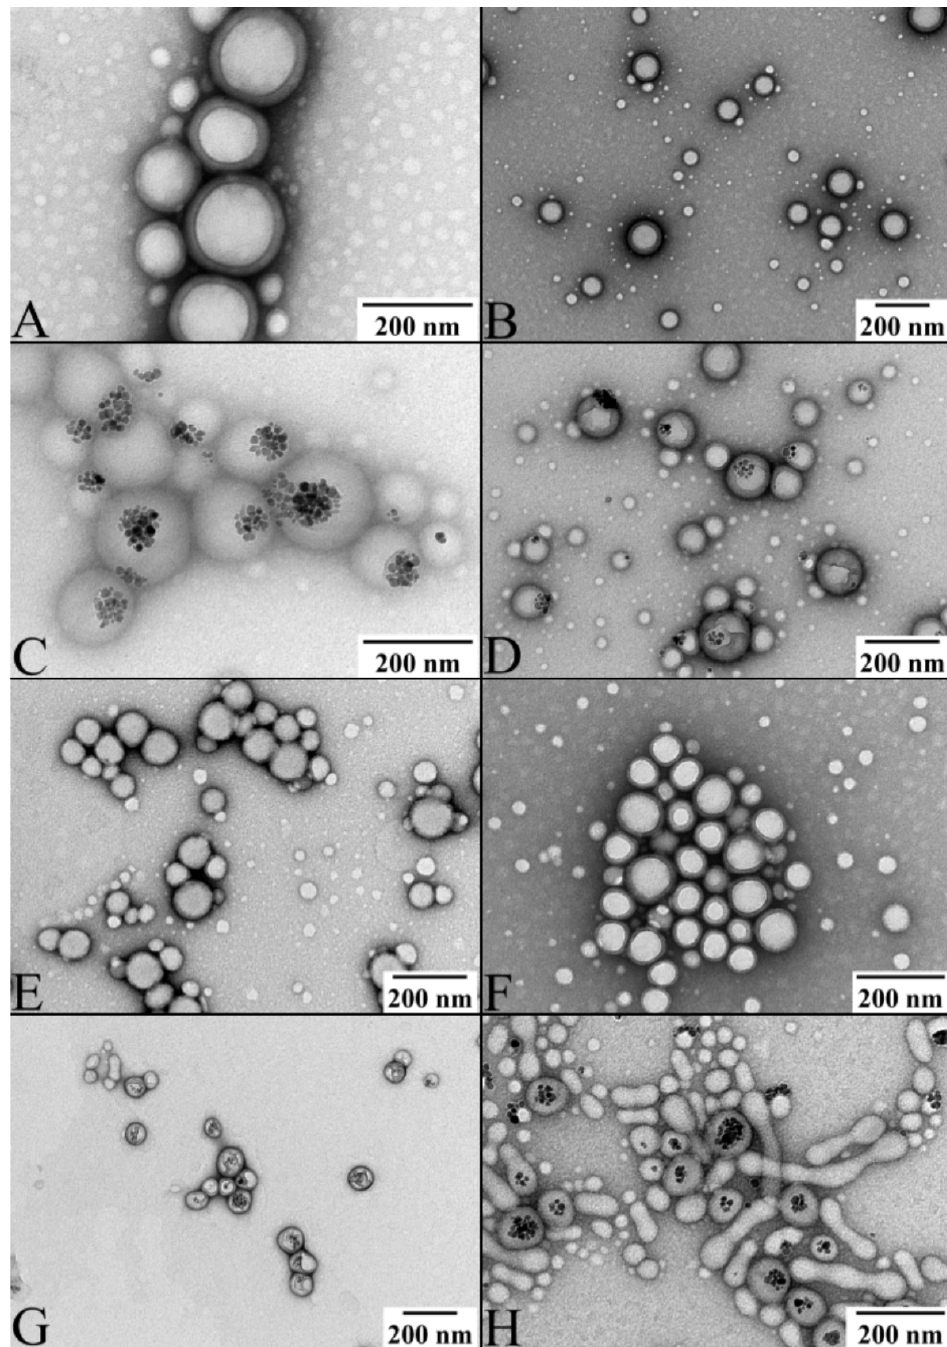
Figure 3. TEM pictures of ( A ) PLGA nanoparticles; ( B ) oxaliplatin-loaded PLGA nanoparticles (PLGA_OXA); ( C ) oleic acid-coated iron oxide-loaded PLGA nanoparticles (PLGA_IO-OA); ( D ) PLGA-based multicomponent delivery systems (PLGA_IO-OA_OXA); ( E ) PEGylated PLGA nanopar- ticles; ( F ) oxaliplatin-loaded PEGylated PLGA nanoparticles (PEGylated PLGA_OXA); ( G ) oleic acid-coated iron oxide-loaded PEGylated PLGA nanoparticles (PEGylated PLGA_IO-OA) and ( H ) PEGylated PLGA-based multicomponent delivery systems (PEGylated